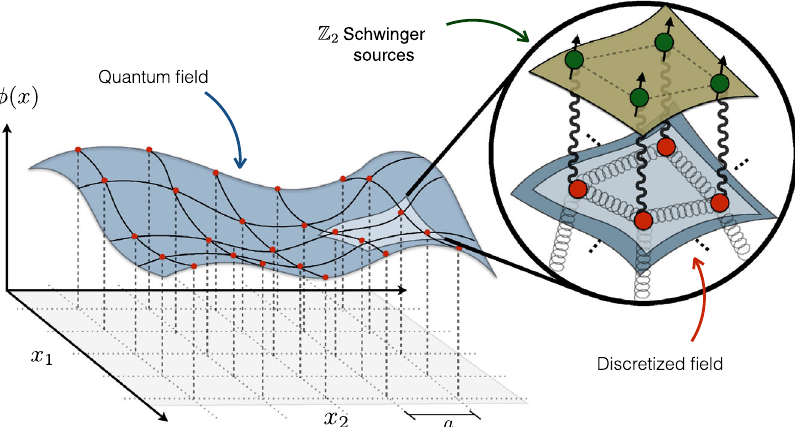
FIG. 1. Schematic representation of the Schwinger sensors for the generating functional. We represent a quantum scalar field ϕ ð x Þ in a D ¼ 2 þ 1 space-time, which is discretized into a d ¼ 2 spatial lattice, while letting the time coordinate continuous. Inset: Zoom of a small space region, where the field at each point (red circles) is coupled to the fields at neighboring points (small springs) and can be excited by its coupling (wavy lines) to generalized quantum-mechanical Schwinger sources (green circles with arrows). These Z 2 Schwinger sources will also function as quantum sensors for the generating